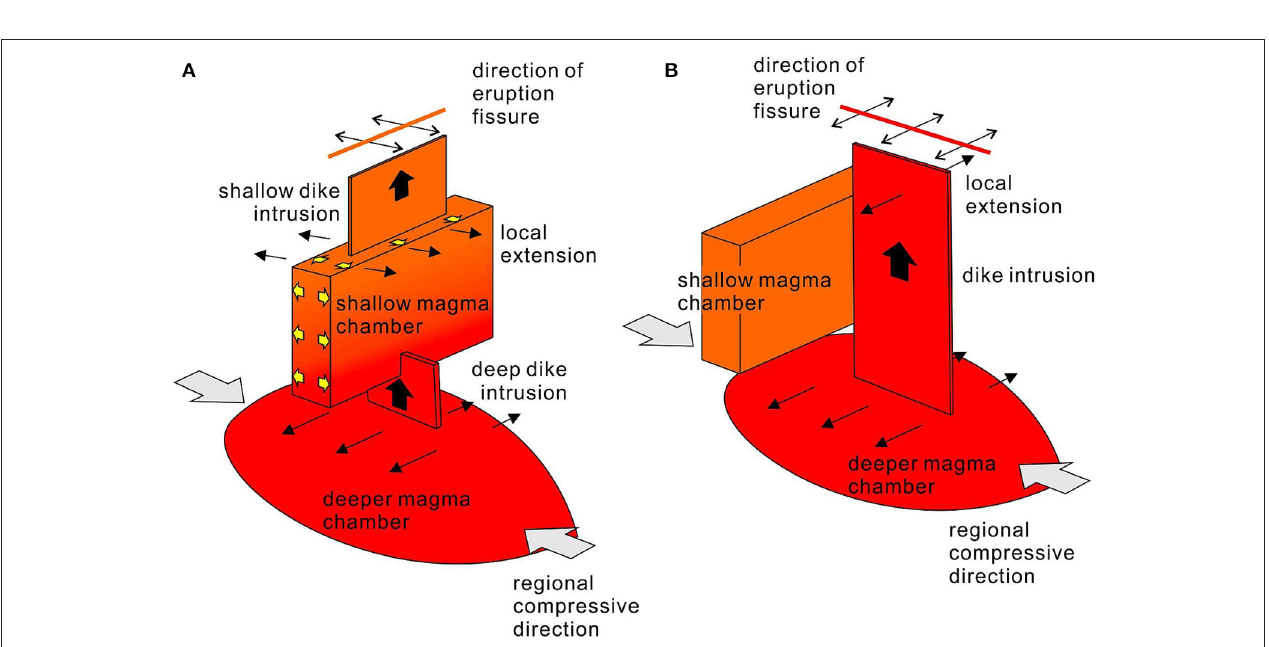
FIGURE 4 | (A) Illustration of the definition of the offset angle of an eruption fissure. (B) Whole-rock SiO 2 content of the ejecta from the flank eruption fissures during the last 2800 years plotted against the offset angle of their eruption fissure.